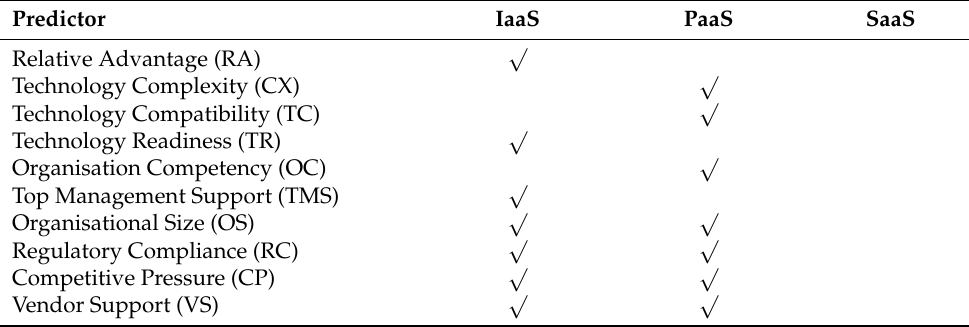
Table 10. Hypothesis testing results per service.